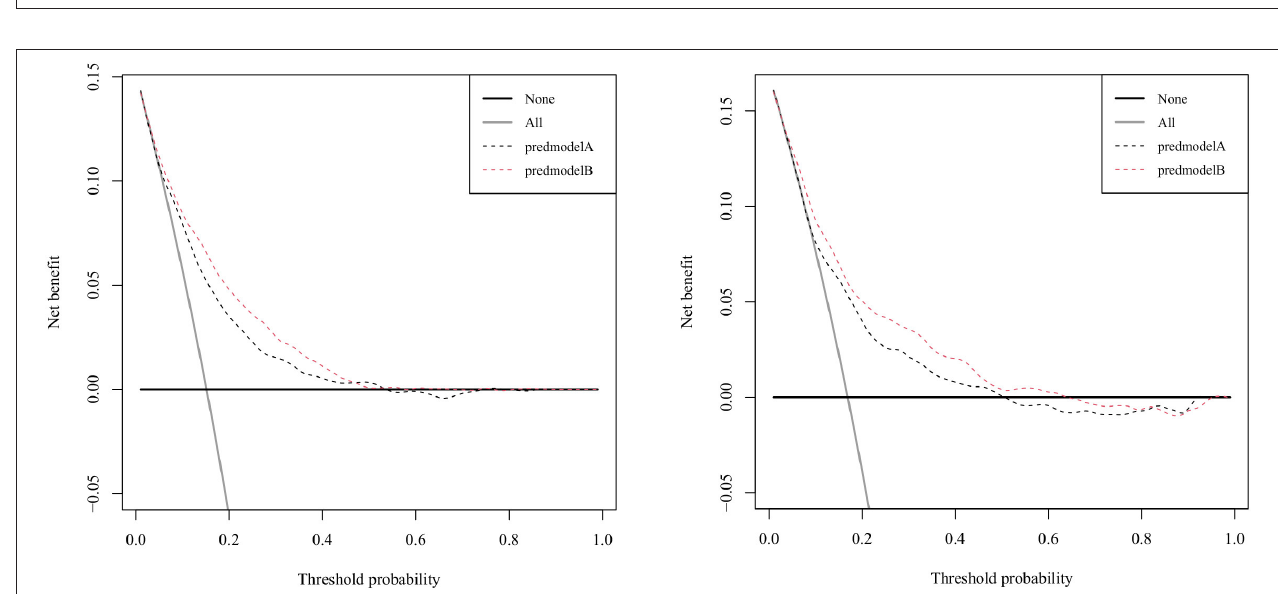
FIGURE 3 | Calibration curves for the validation cohort and the training cohort.